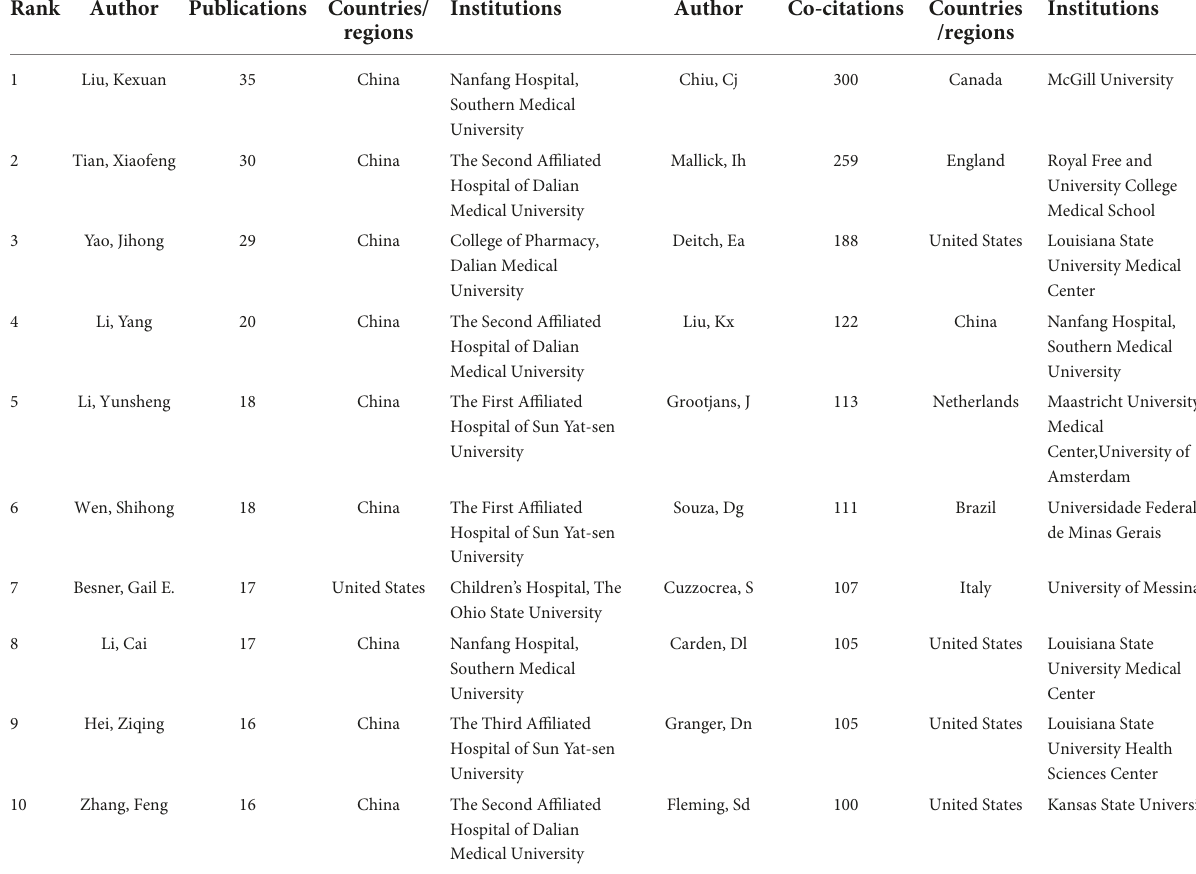
TABLE 3 Top 10 authors in terms of number of publications and frequency of